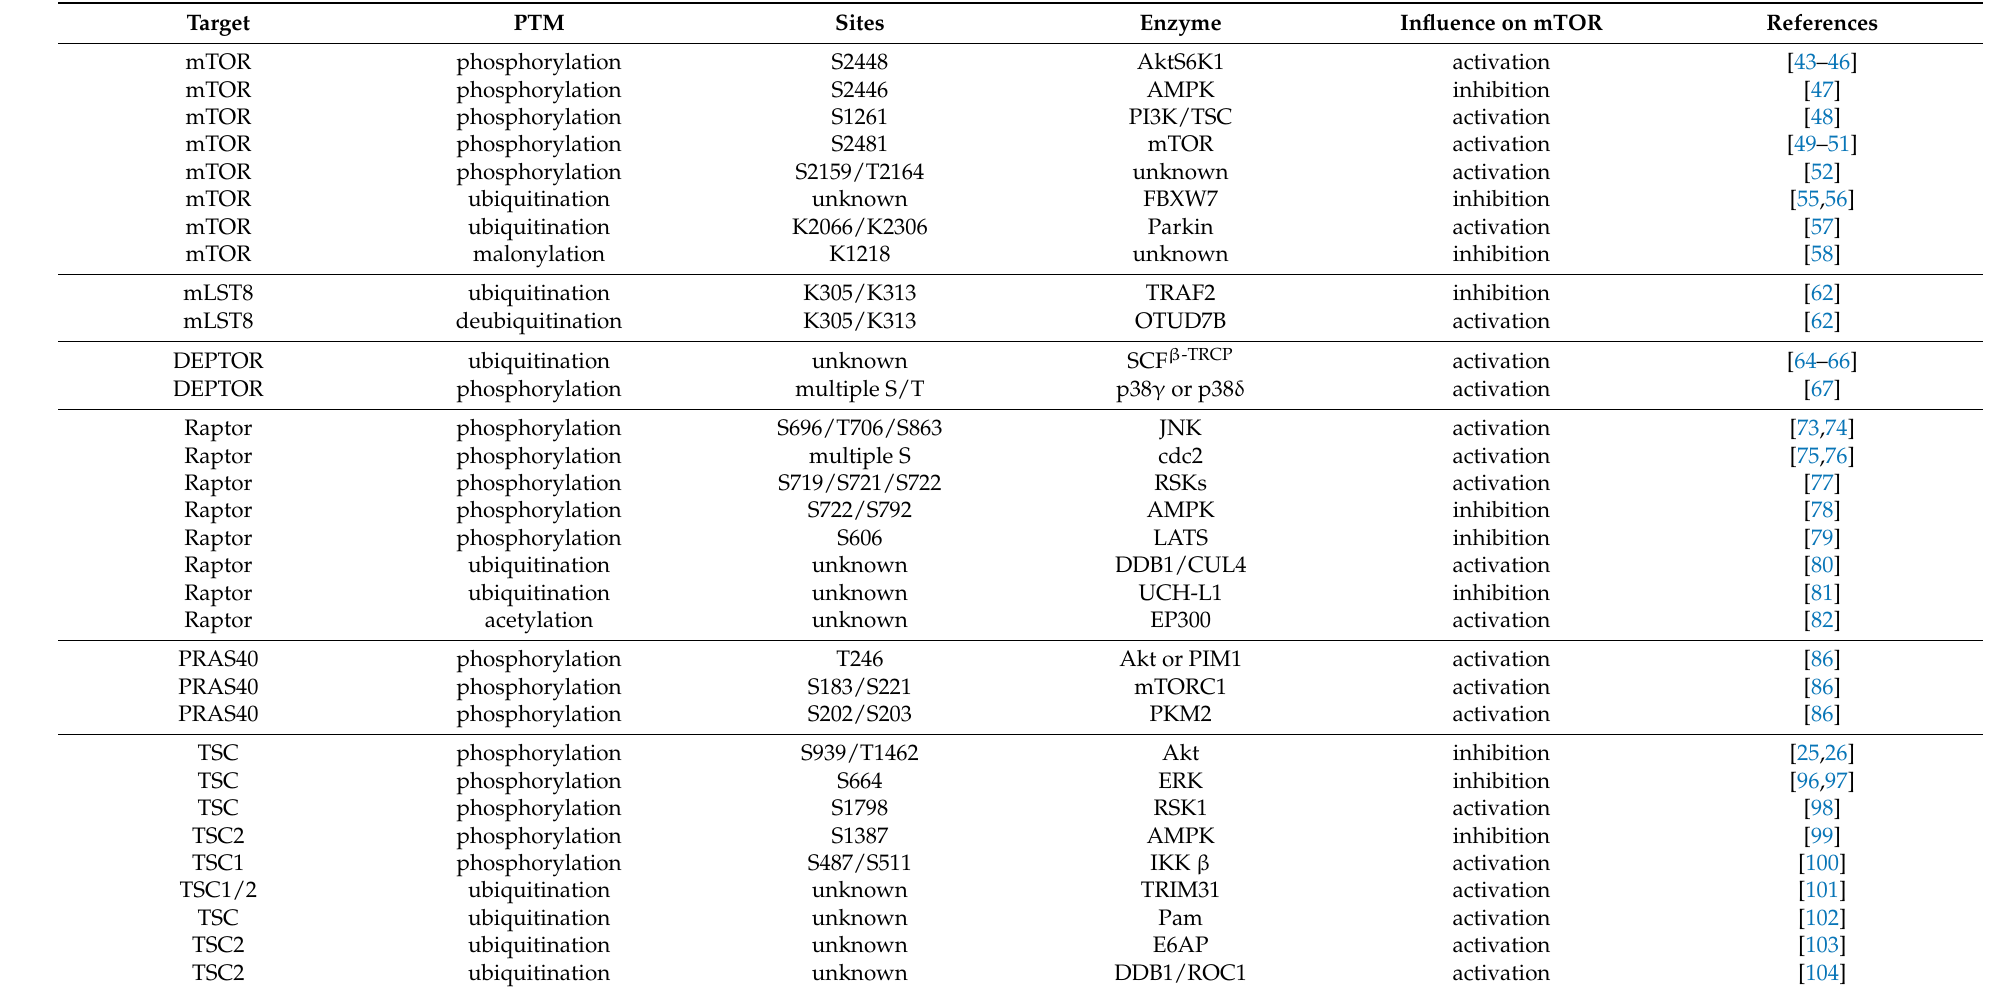
Table 1. Major post-translational modifications (PTMs) of the mTOR signaling